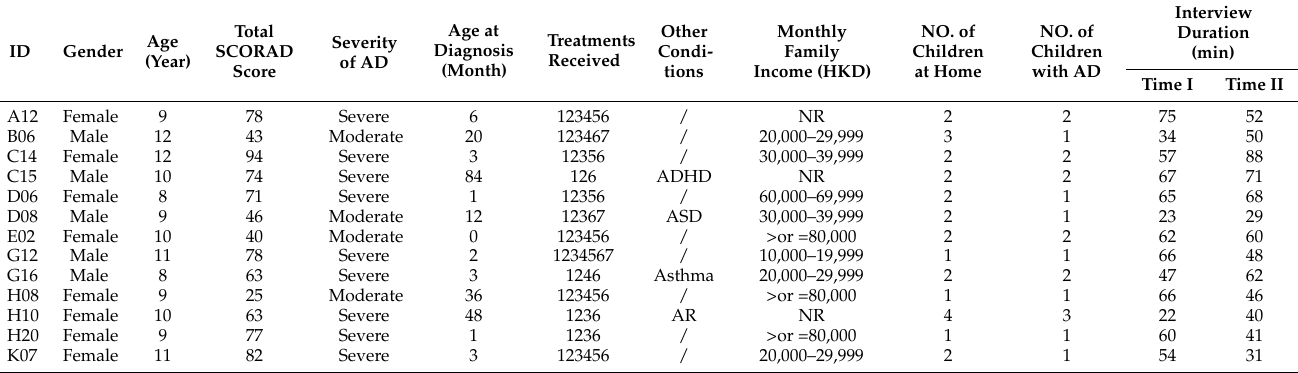
Table 2. Characteristics of participating children.